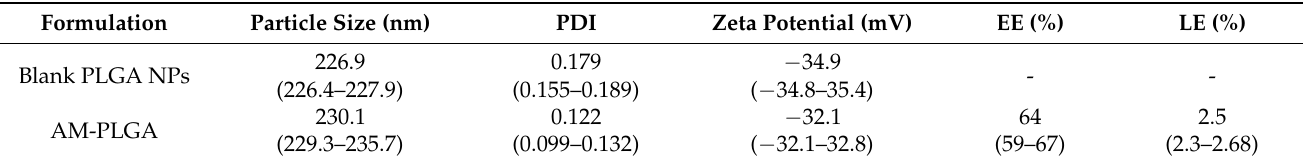
Table 1. Physical and pharmaceutical properties (particle size, PDI, zeta potential, %EE, and %LE) of the blank PLGA-NPs and the